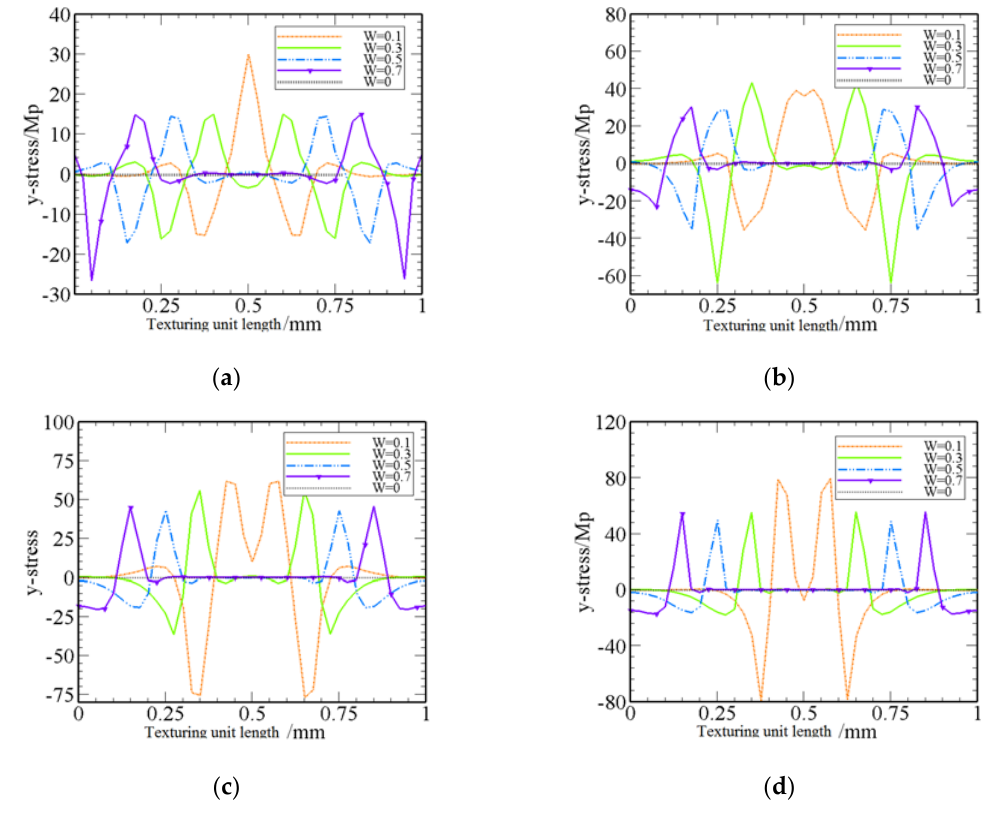
Figure 5. Distribution of stresses along the y direction at different texturing widths: ( a ) H = 0.1; ( b ) H = 0.3; ( c ) H = 0.5; ( d ) H = 0.7.